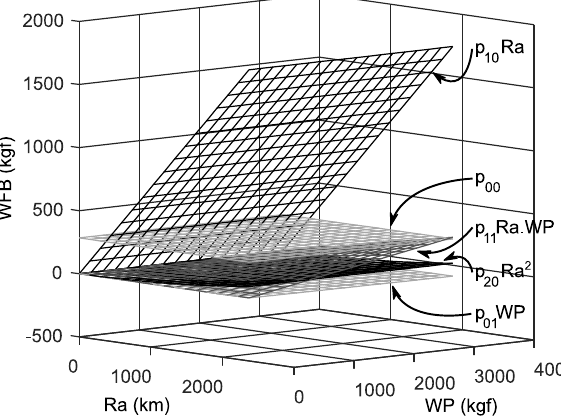
Figure 3. Relative magnitude of the p-terms for an aircraft at constant altitude.